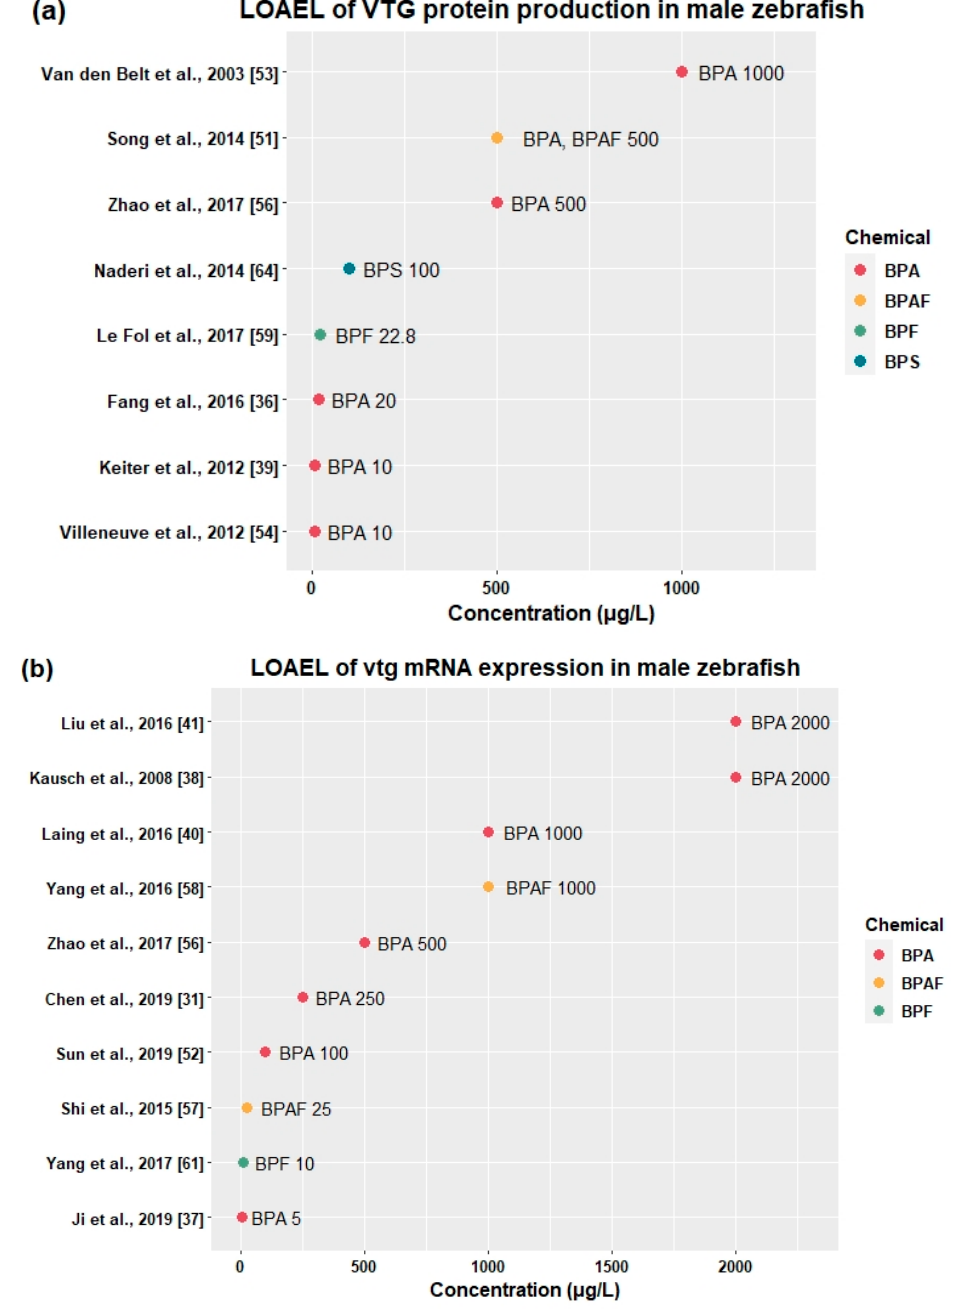
Figure 3. Lowest observed adverse effect level (LOAEL) of vitellogenin protein production ( a ) and vitellogenin mRNA expression ( b ) in male zebrafish exposed to BPA, BPAF, BPF, and BPS.